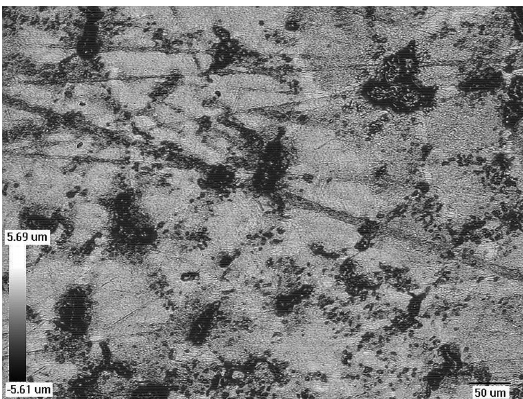
Figure 3. Confocal surface microscopic image showing the two phases present in ceramic foam: mullite (white) and alumina-rutile enrichment areas (black). Straight lines observed might be due to different thicknesses of material from the slurry during preparation or to irregularities in the sacrificial polymer template.